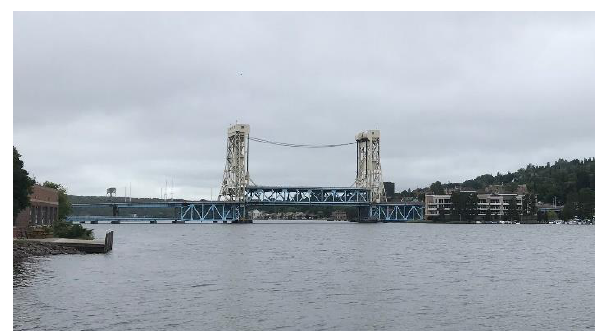
Figure 4. Hancock-Houghton Lift Bridge